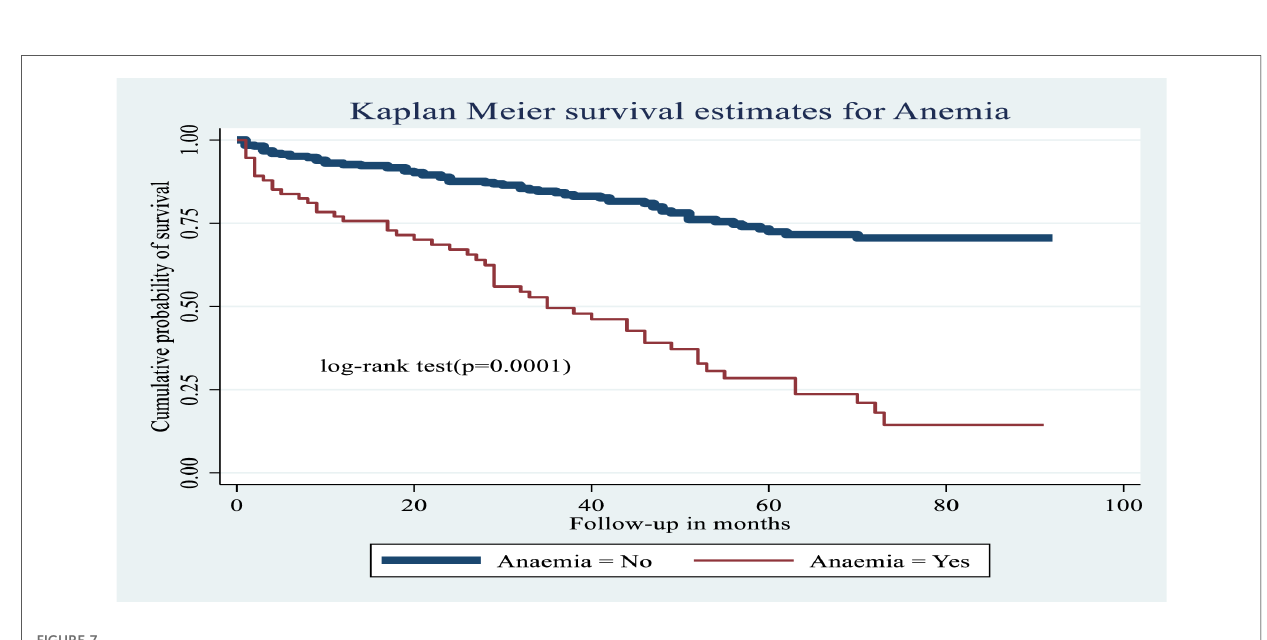
FIGURE 7 Kaplan – Meier estimates of probability of OI-free survival with and without anemia among HIV-infected children receiving ART at Amhara regional state comprehensive specialized hospitals, Ethiopia, 2022.